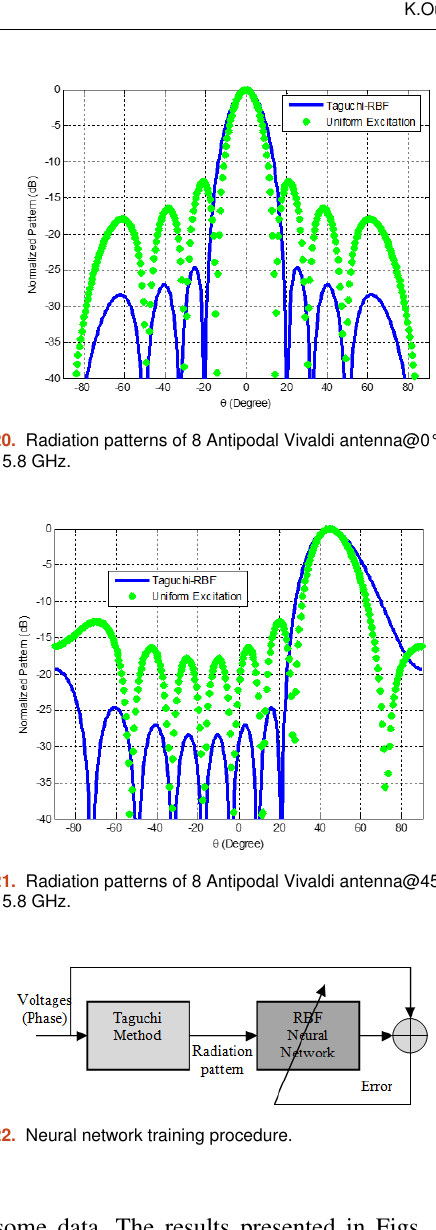
FIGURE 19. Radiation patterns of 8 Antipodal Vivaldi antenna@-45° and frequency 5.8 GHz.